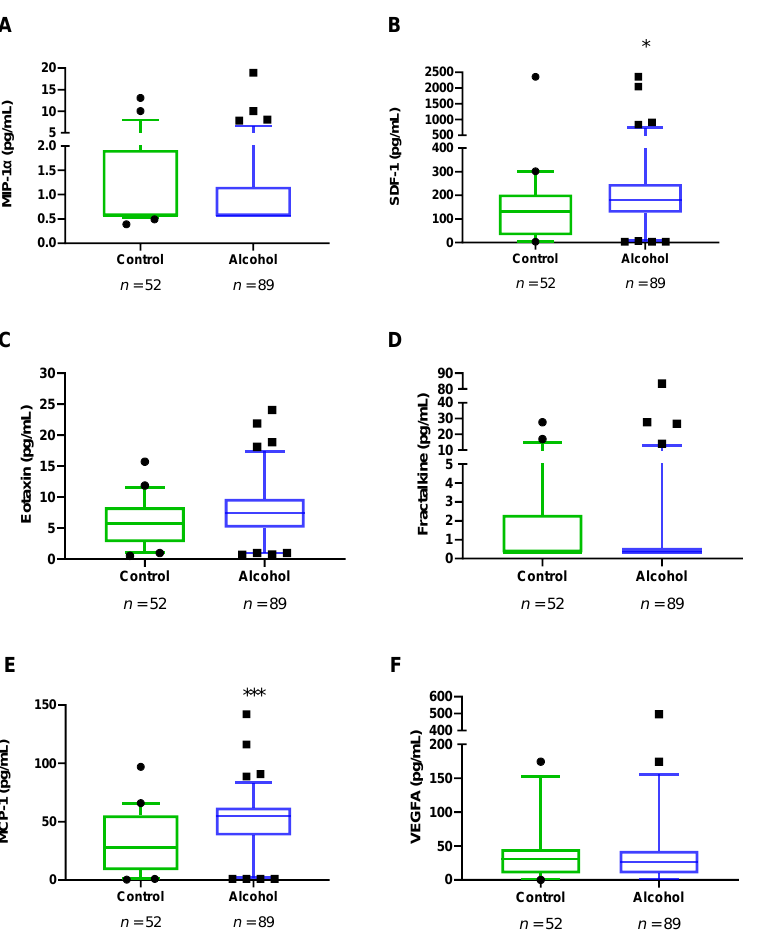
Figure 2. Plasma concentrations of VEGFA and chemokines in the alcohol group vs the control group ( n = 141). ( A ) MIP-1 α (pg/mL), ( B ) SDF-1 (pg/mL), ( C ) Eotaxin (pg/mL), ( D ) Fractalkine (pg/mL), ( E ) MCP-1 (pg/mL), and ( F ) VEGFA (pg/mL). Box and whiskers plotted at the 5–95 percentile. Dots are individual values. Data were analyzed by Mann–Whitney U -test. (*) p < 0.05 and (***) p < 0.001 denote significant differences compared with the control group.